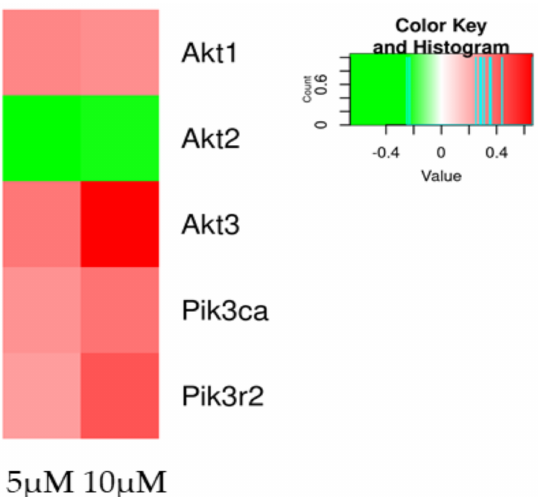
Figure 3. Heatmap of DEGs involved in the DEGs involved in the PI3K/AKT pathway genes in the comparison of CTRL vs. 5 µ M (left column of each comparison) or CTRL vs. 10 µ M (right column of each comparison). The green scale is related to downregulated genes, whereas the red palette represents upregulated ones. Gray is used when the difference is not statistically relevant in the comparison.